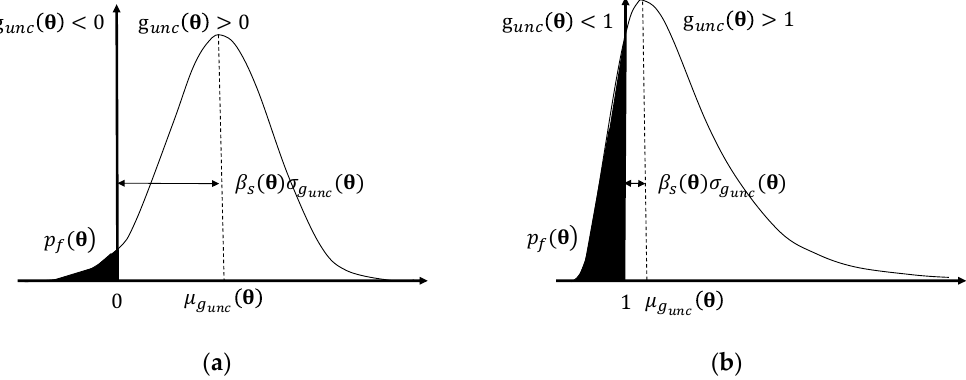
( θ ) : ( a ) g ( θ ) unc unc